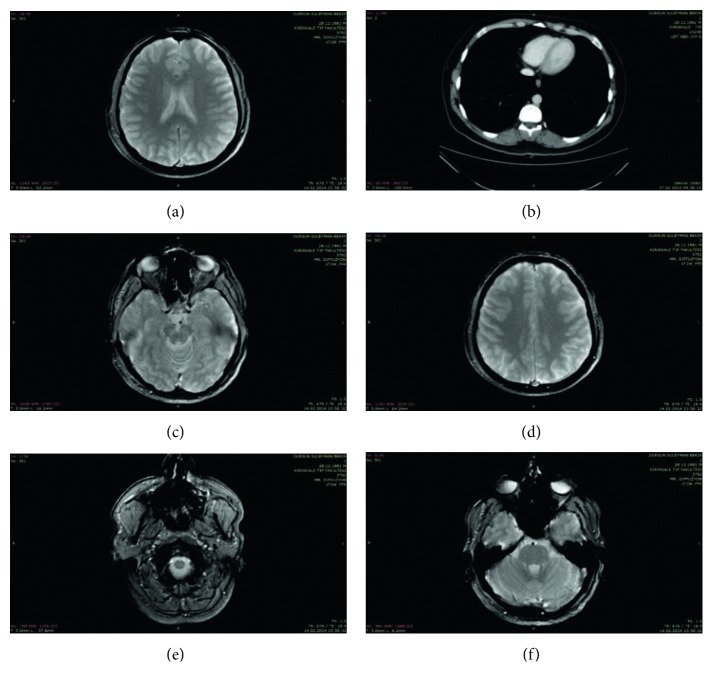
Test medical images.